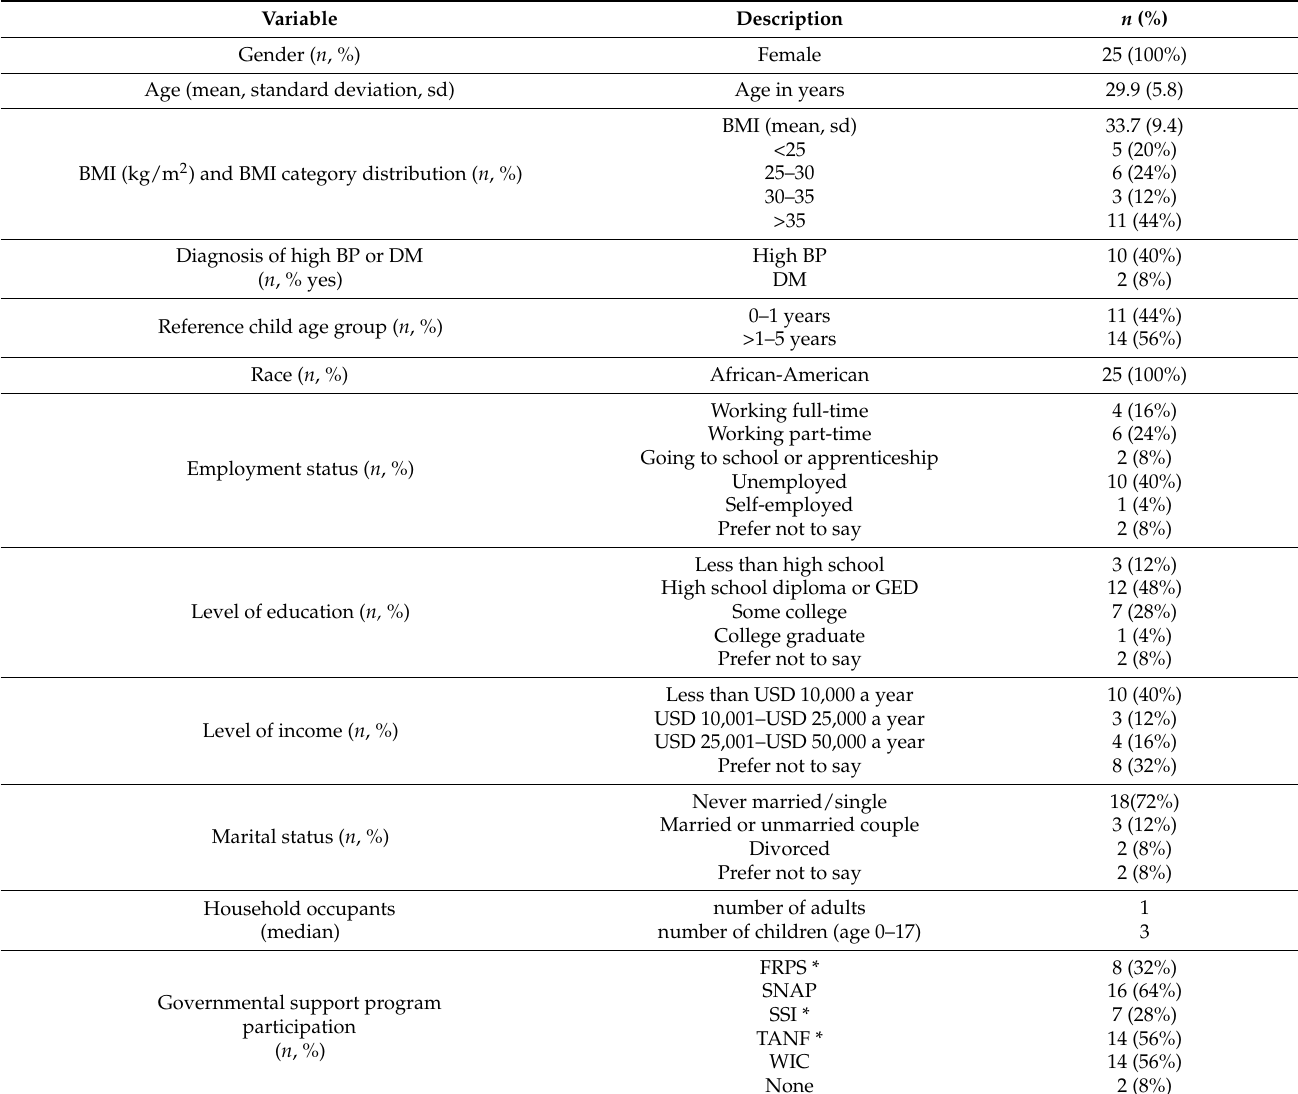
Table 1. Baseline demographic data of